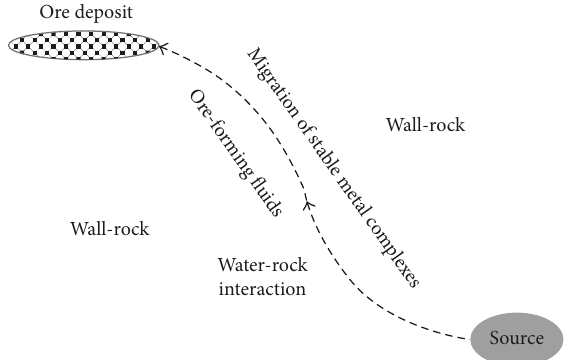
Figure 1: Sketch on the forming process of hydrothermal ore